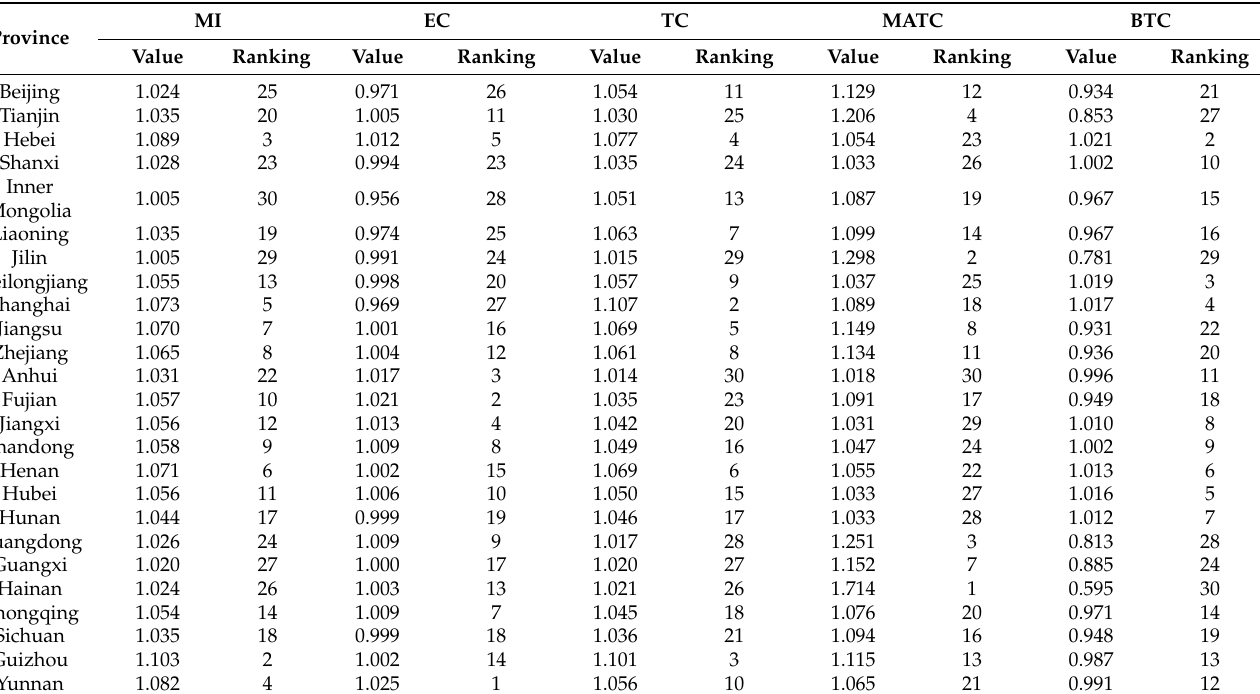
Table 3. Average rural energy carbon emission efficiency of 30 provinces in China from 2006 to